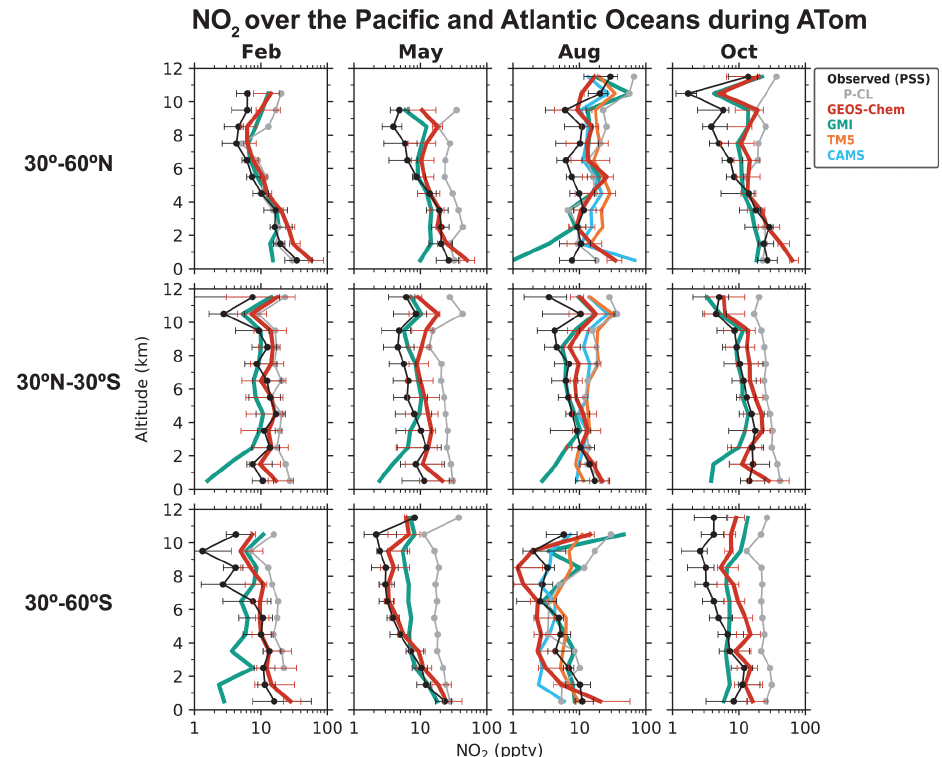
Figure 4. Median vertical profiles of NO 2 concentrations over the Pacific and Atlantic oceans during the ATom flight campaigns (2016– 2018), separated by seasons and latitude regions. Observations are based on the photochemical steady state (PSS) with local measurements of NO concentrations and other quantities, following Eqs. (2) and (3). Horizontal bars show the interquartile ranges in 1km altitude bins. The data selection criteria are as described in the caption of Fig. 1. NO 2 measurements from the P-CL instrument are also shown for reference. Model results are from our baseline GEOS-Chem simulation (including p NO − photolysis), GMI, TM5, and CAMS, which are sampled 3 along the flight tracks. The TM5 and CAMS NO 2 profiles are available only for August. NO 2 concentrations are plotted on a log scale. For clarity, the interquartile ranges for the GMI, TM5, and CAMS profiles are shown separately in Fig.